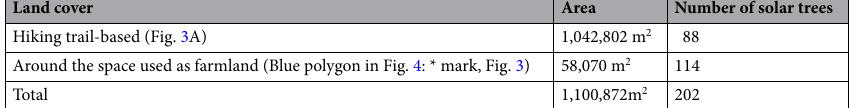
Land cover Area Number of solar trees Hiking trail-based (Fig.